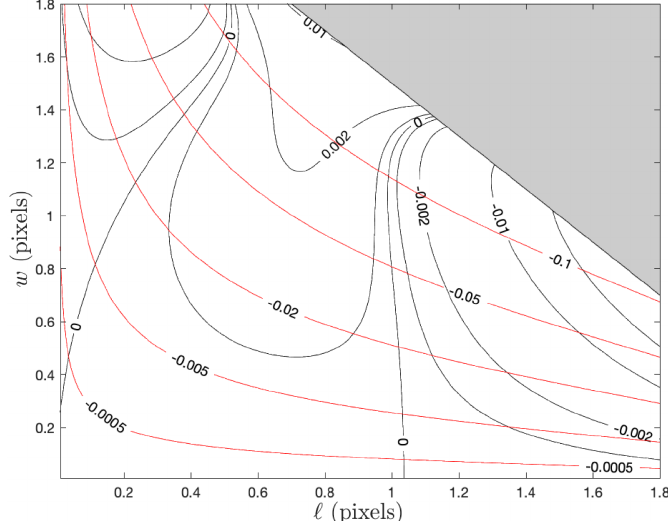
Figure 4. Contours of edge localization error for a continuous (not pixelated) ramp edge signal. Black contours show the error when using the approximation from Equation (41), red contours show the error when using the step function approximation from